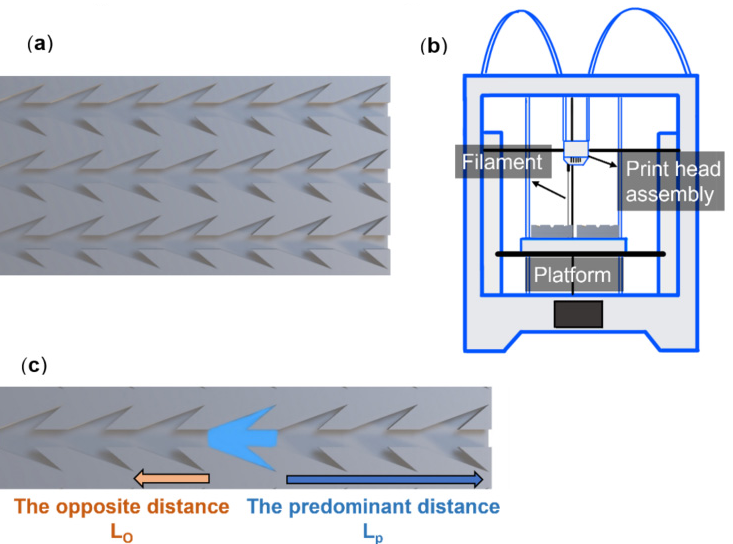
Figure 2. ( a ) Three-dimensional model of dart-shaped structure array; ( b ) The illustration of FDM 3D printer; ( c ) The length of directional